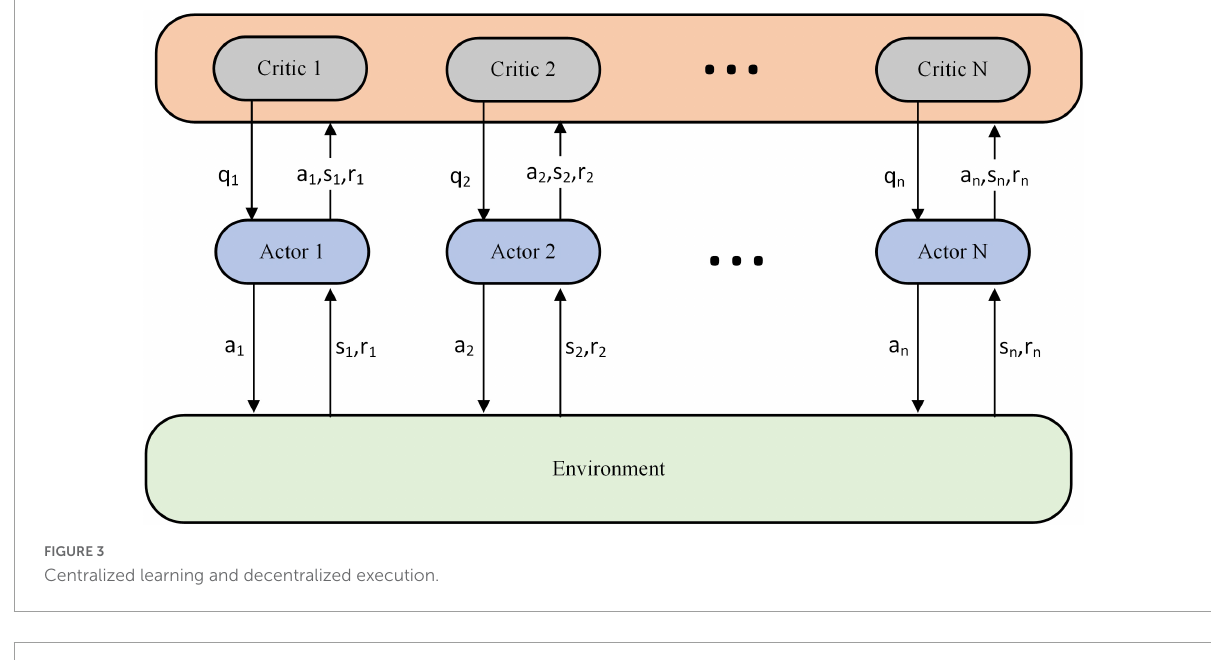
FIGURE3 Centralized learning and decentralized execution.